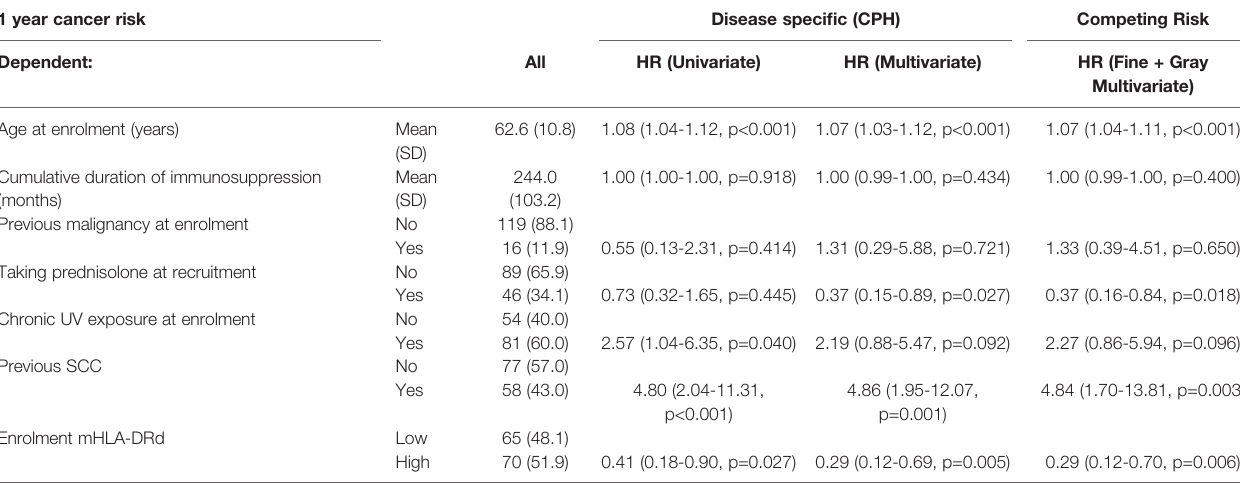
Allfactorsanalysedforunivariatesigni fi cantwereincludedinmultivariatemodelsasapre-speci fi edanalysis.Ageatrecruitmentandageatlasttransplantdemonstrated strongcorrelation, asdidnumberofimmunosuppressiveagentsandtheuseofprednisoloneatrecruitment,andsoonlyageanduseofprednisoloneatrecruitmentwereusedinthemultivariatemodels.Two models were generated: one using Cox Proportionate Hazards modelling and a second using competing-risk modelling, using graft loss and death as competing